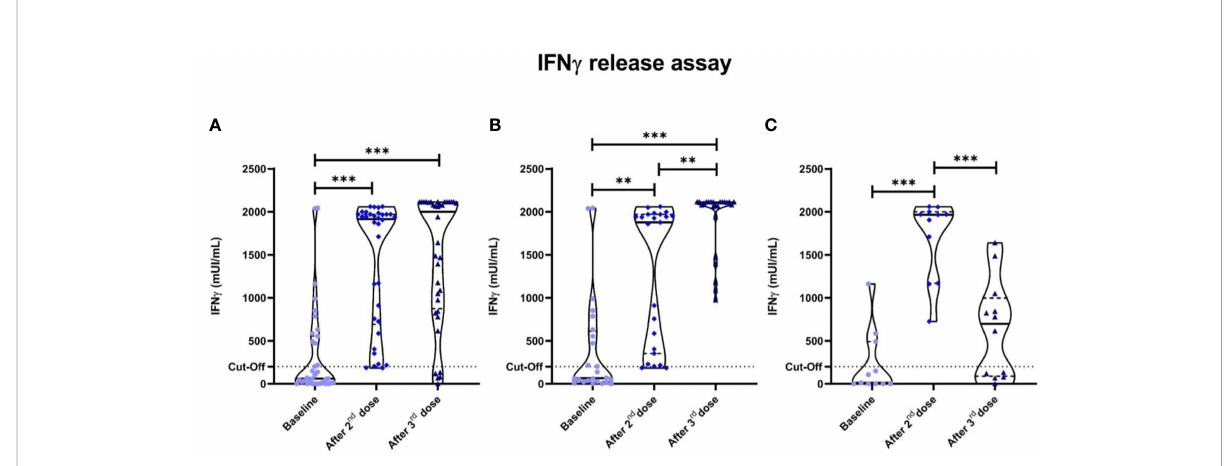
FIGURE 2 Speci fi c anti-SARS-CoV-2 IFN- g responses measured by IGRA. Dotted lines represent positivity cut-off: ≥ 200 mUI/ml. (A) All cancer patients. Signi fi cant differences were seen in cancer patients between the baseline anti-SARS-CoV-2 IFN- g titres and after the second ( p <0.001) and third vaccine doses ( p <0.001). Two groups were established after the third dose according to the pattern of cellular behavior: one that enhanced their IFN- g titres after the third vaccine dose (Group 1); and Group 2 that displayed a drastic fall-off of speci fi c anti-SARS-CoV-2 IFN- g titres. (B) Group 1 cancer patients. (C) Group 2 cancer patients. * P <0.05 ** P <0.01 *** P